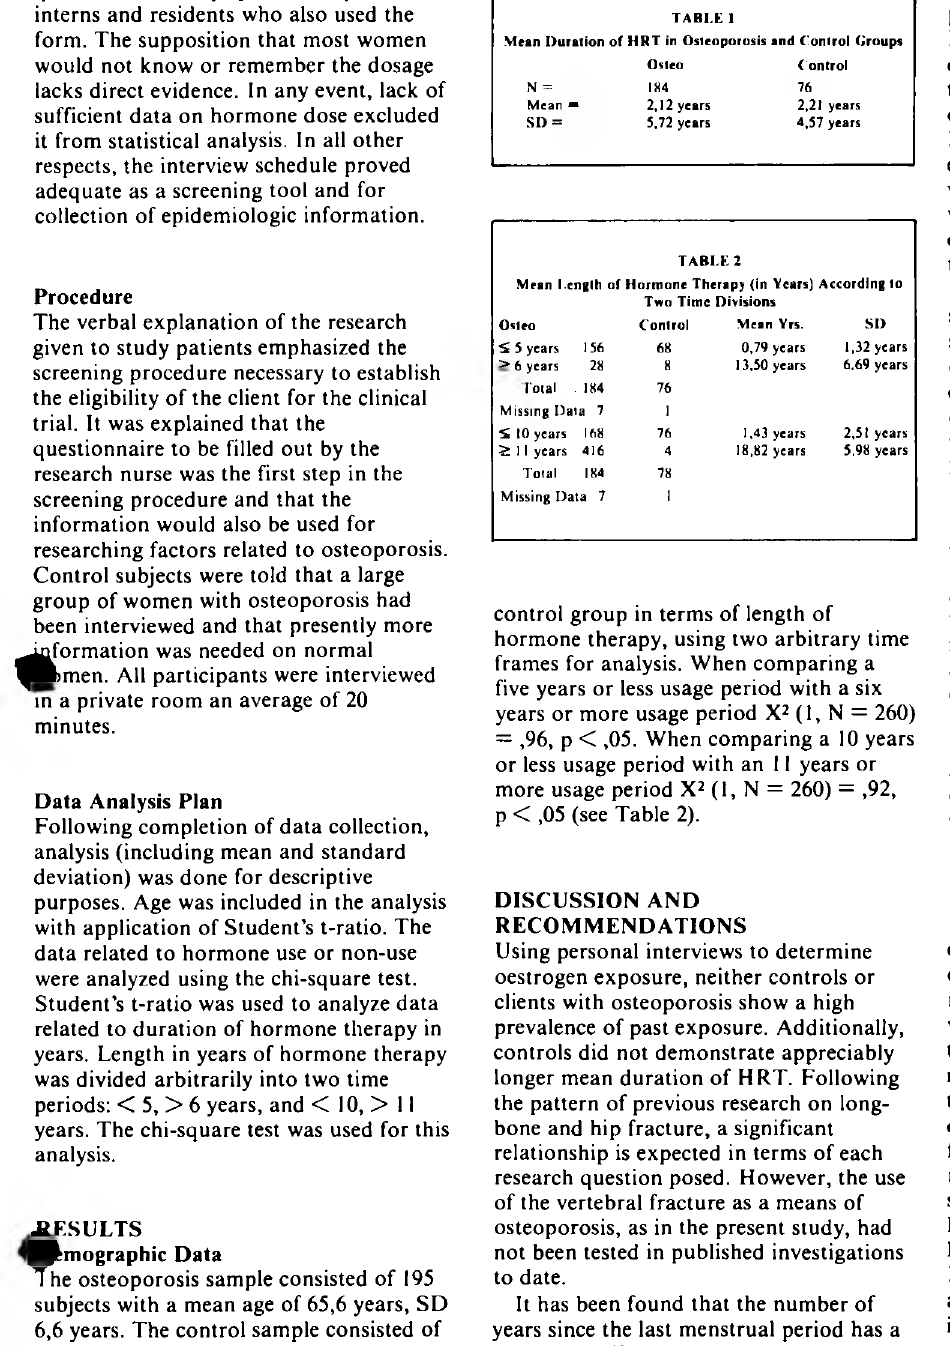
TABLE 1 Mean Duration of HRT in Osteoporosis and Control Groups